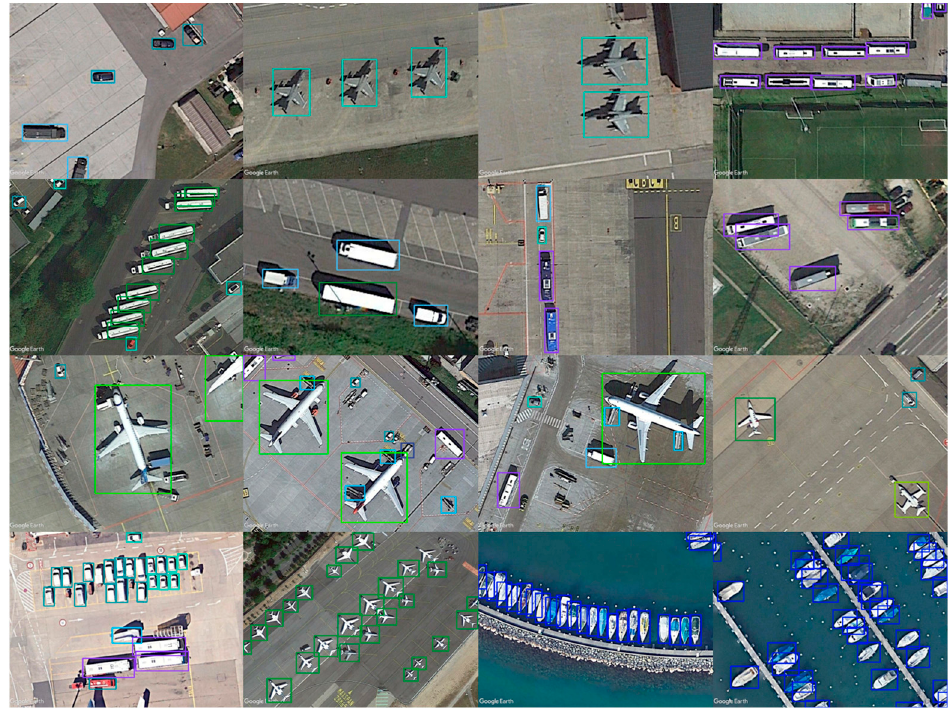
Figure 8. Some detection results on the SIMD dataset of YOLO-HR.